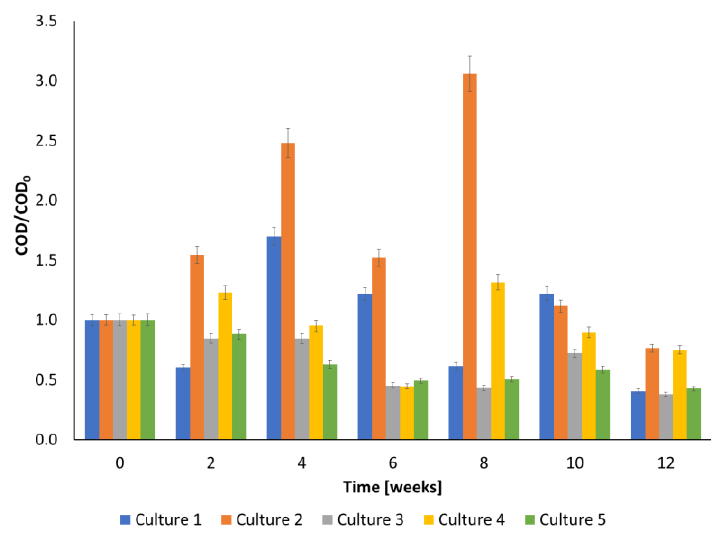
Figure 3. Changes in the COD during the biodegradation process of creosote oil.